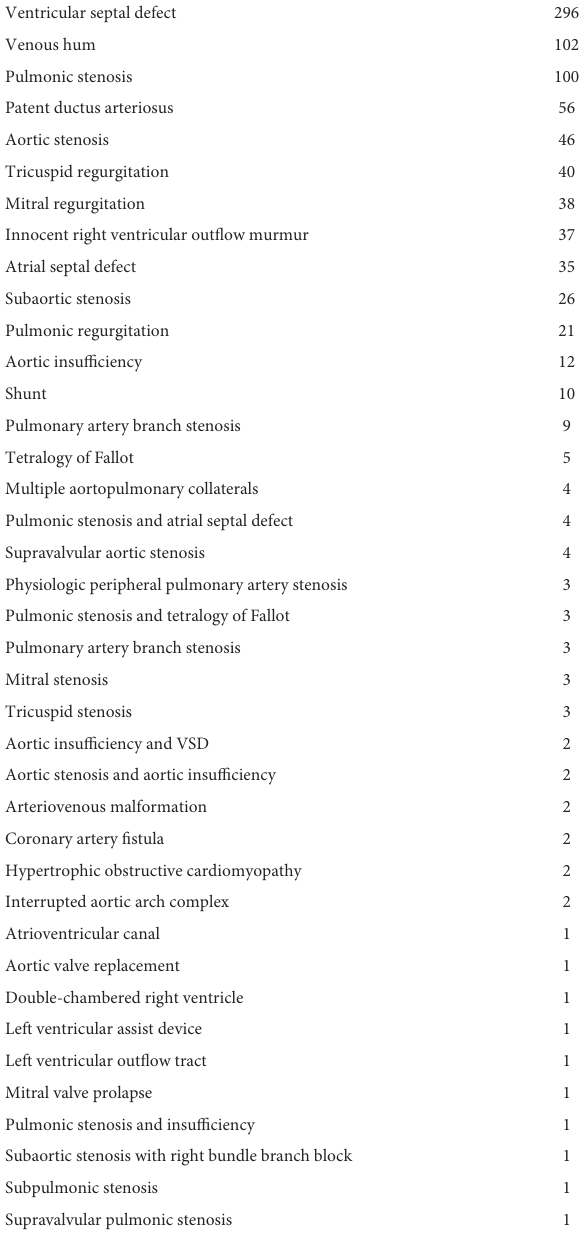
TABLE 1 Number of heart sound recordings organized by clinical diagnosis and recording location used in the study. Recording